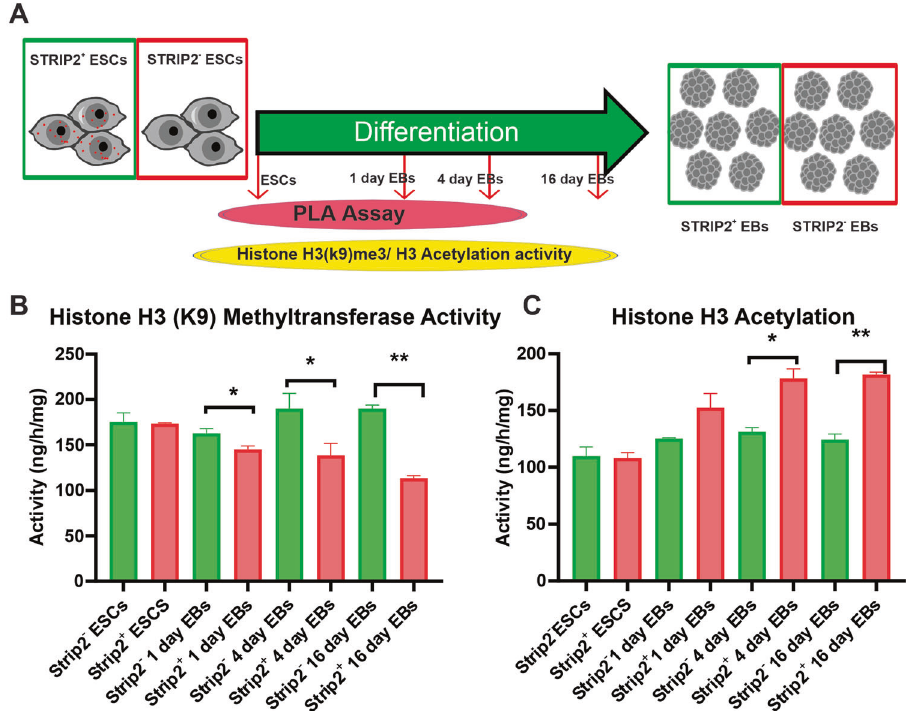
Fig. 6 Proximity ligation assay and enzyme assay results. A Schematic work fl ow represents the analysis of proximity ligation assay (PLA) and enzyme assay at different points of differentiation between Strip2 − -ESCs and Strip2 + -ESCs. B Quanti fi cation of H3K9 methyltransferase activity in undifferentiated and differentiated Strip2 − -ESCs and control Strip2 + -ESCs, respectively ( n = 3). Mean ± SEM values are shown. C Histone H3 acetylation activity in undifferentiated and differentiated Strip2 − -ESCs and control Strip2 + -ESCs, respectively (Mean ± SEM values, n = 3). SEM: Standard error of the